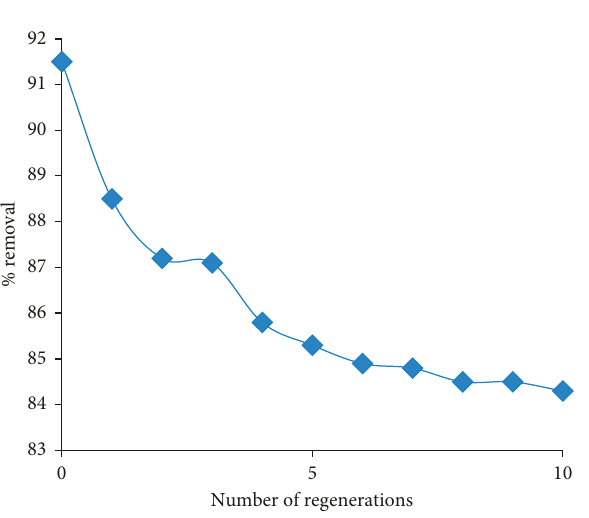
Figure 15: Number of regenerations versus % removal.